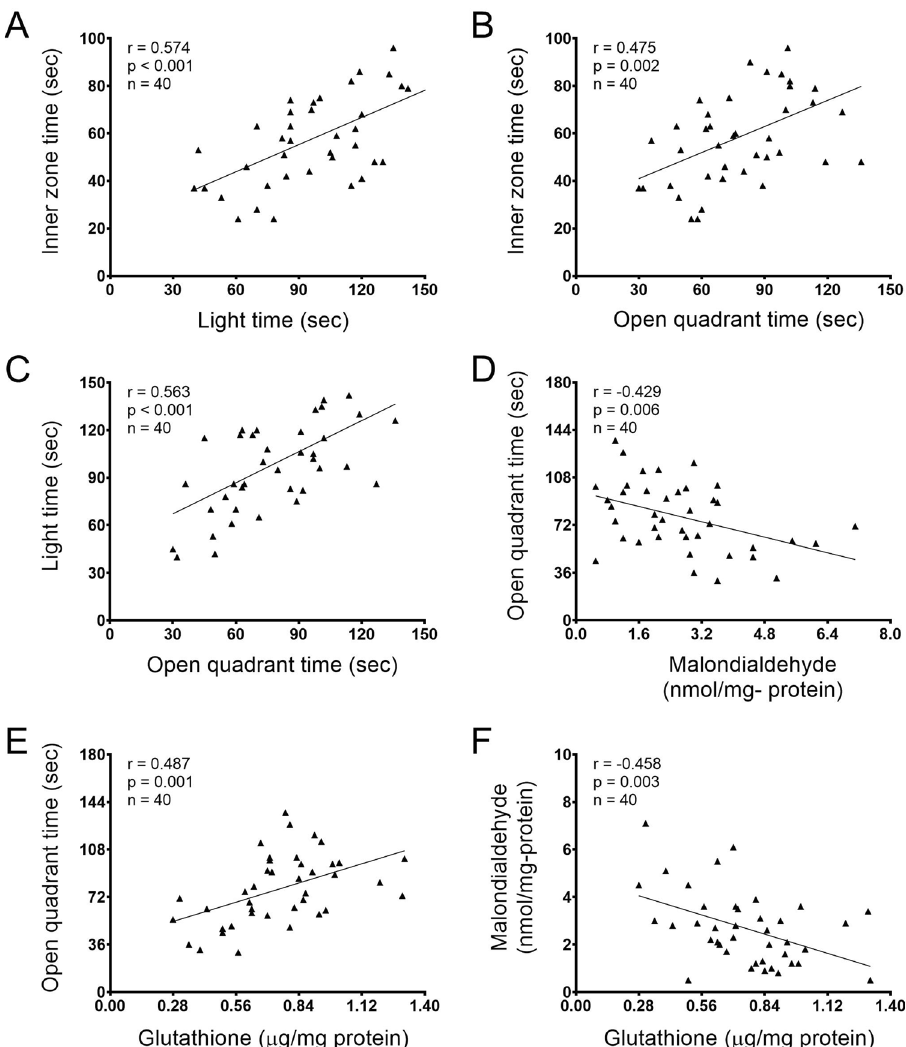
Figure 5. Pearson correlations between anxiety tests and/or oxidative stress/antioxidant markers. Correlation coefficient: r; the number of animals: n; p-value: